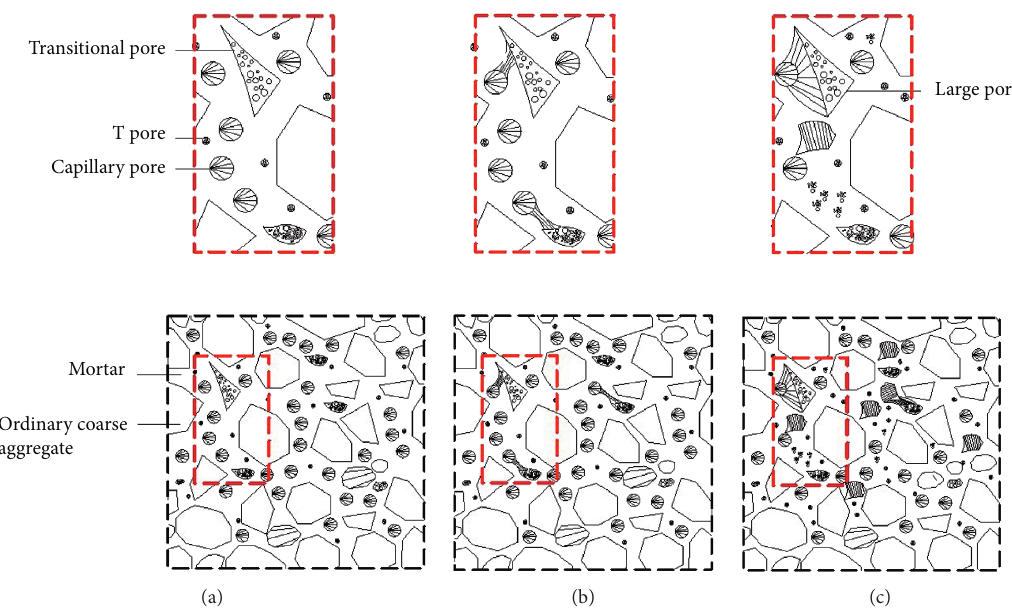
Figure 12: Schematic diagram of internal variation of ordinary concrete C0 freeze-thaw.